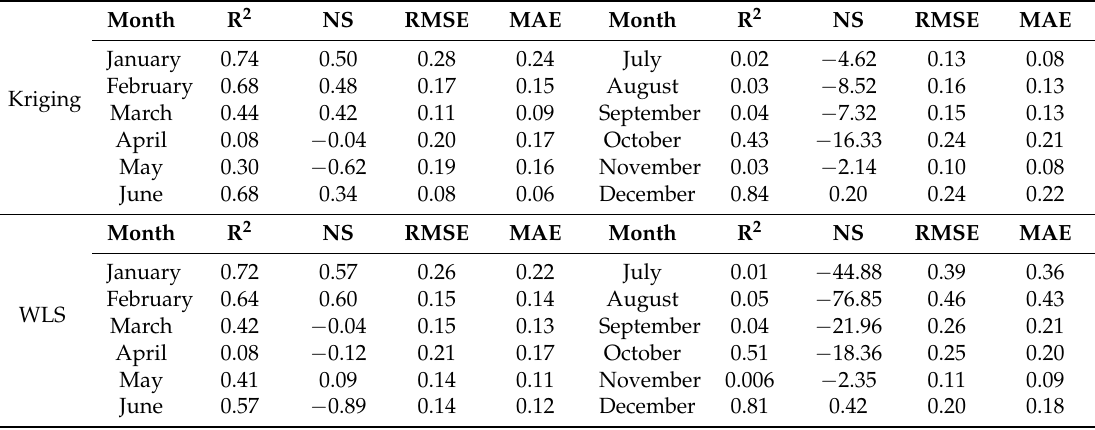
Table 5. Monthly R 2 , NS, RMSE and MAE values for the years 2003 till 2015 for simulated LAI ( top : Equation (9), bottom : Equation (10)) vs. MODIS LAI.